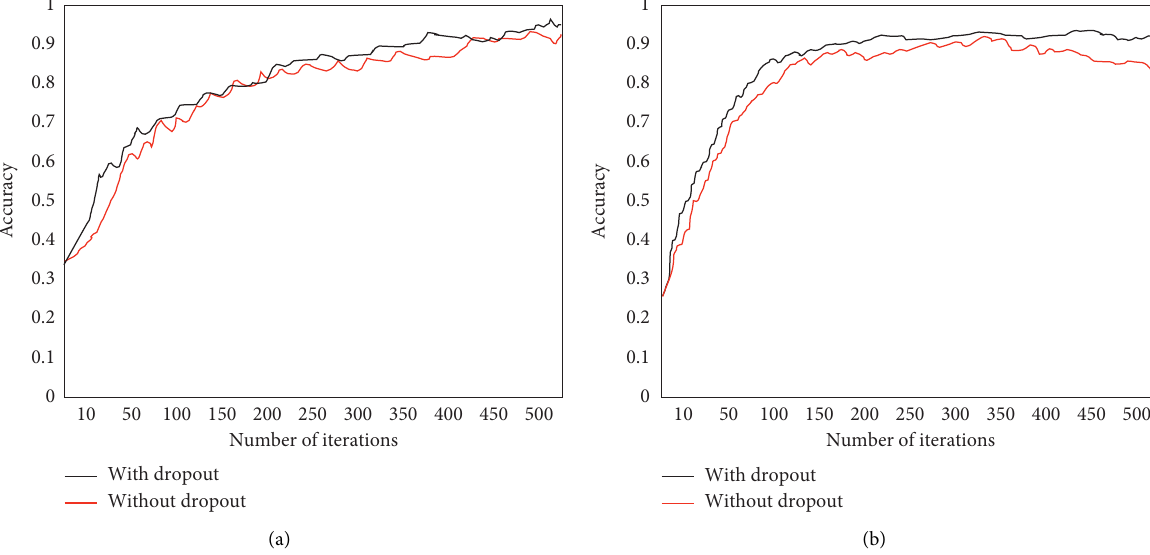
Figure 7: Accuracy curve of test samples with the number of iterations. (a) Accuracy in HMDB51 dataset. (b) Accuracy in UCF-101